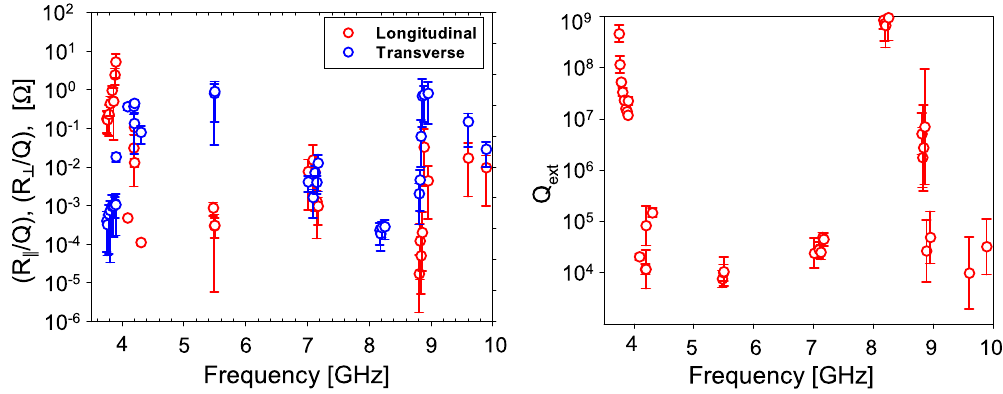
FIG. 12. Spread of HOM parameters for high-risk trapped modes in the 3.9 GHz LCLS-II cavity.